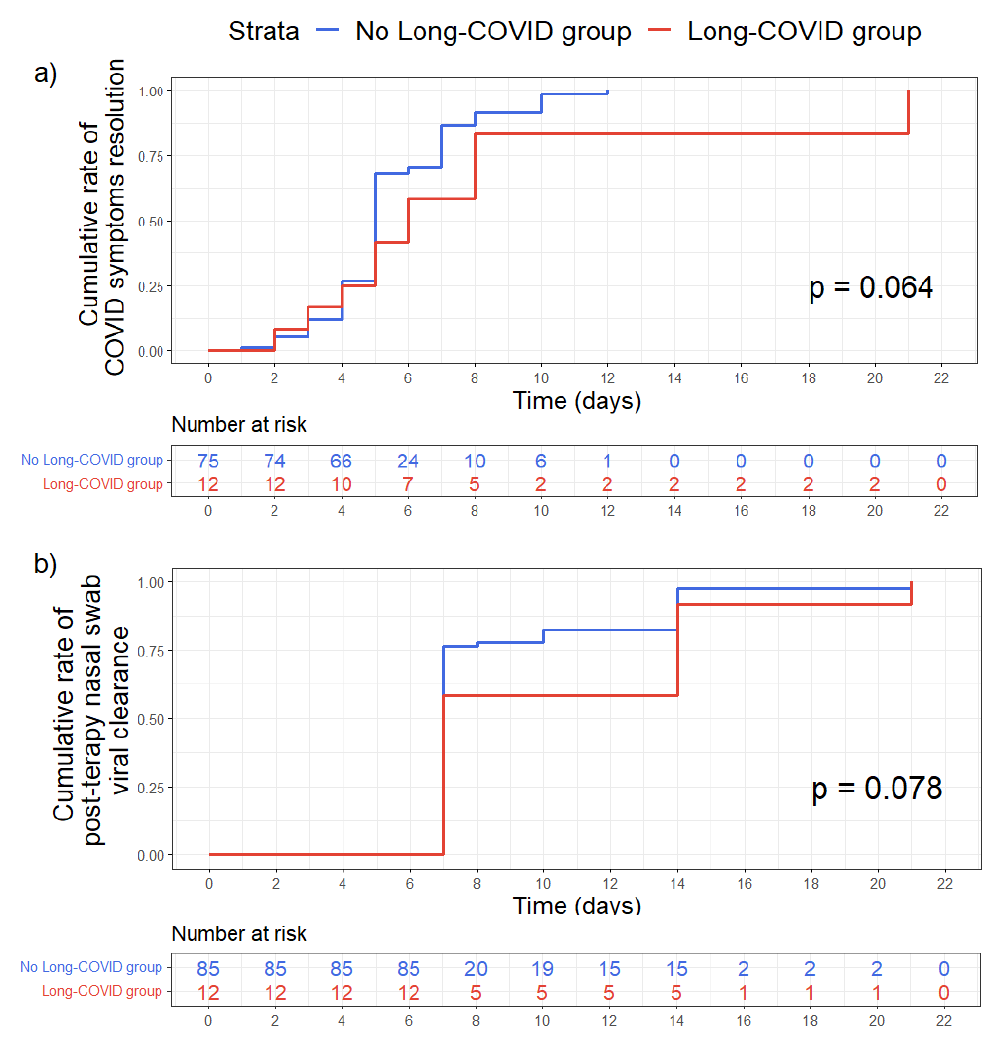
Figure 2. Kaplan–Meier curves comparing time-to-event between Long-COVID group (red) and No Long-COVID group (blue). ( a ) Time in days of COVID symptoms resolutions. ( b ) Time in days to obtain the first negative nasal swab after therapy. The reported p values resulted from Log-rank test. Time-to-event were assessed with Kaplan – Meier plot and compared with log rank test.